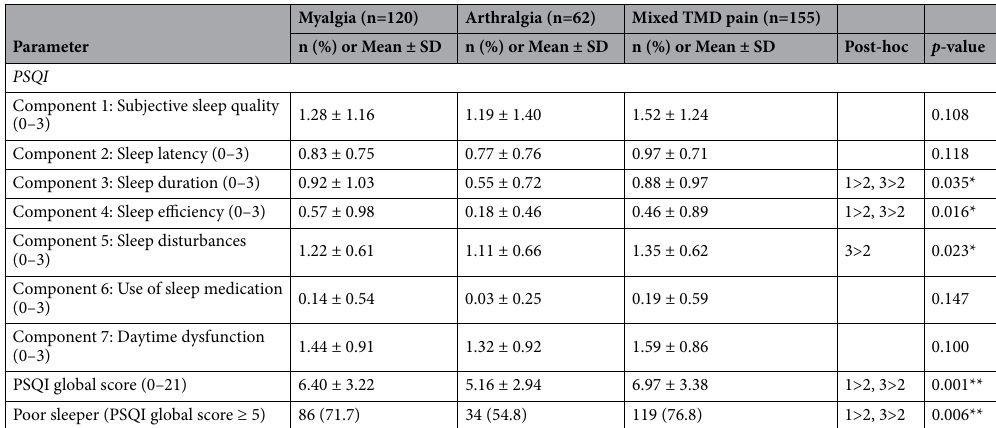
Table 2. Comparison of Pittsburgh Sleep Quality Index (PSQI) between TMD groups. The results were obtained from χ 2 test with Bonferroni adjusted post hoc analysis and the mean difference between groups was obtained by ANOVA) with Tukey’s post-hoc test. p -Value significance was set at <0.05. *: p -value <0.05, **: p -value <0.01. TMD: temporomandibular disorder, VAS: visual analogue scale, SD: standard deviation, 1 in Post-hoc test: the mean value of myalgia group, 2 in Post-hoc test: the mean value of arthralgia group, 3 in Post-hoc test: the mean value of mixed TMD pain